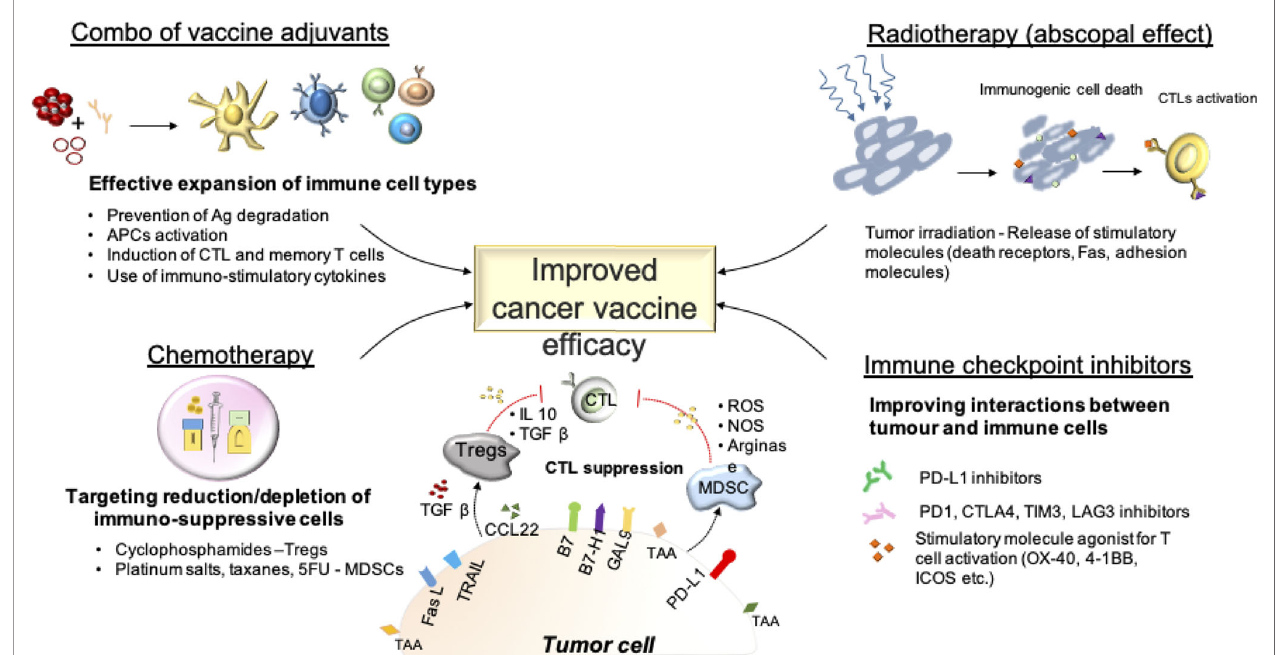
FIGURE 3 | Improving the ef fi cacy of cancer vaccines: Combinational